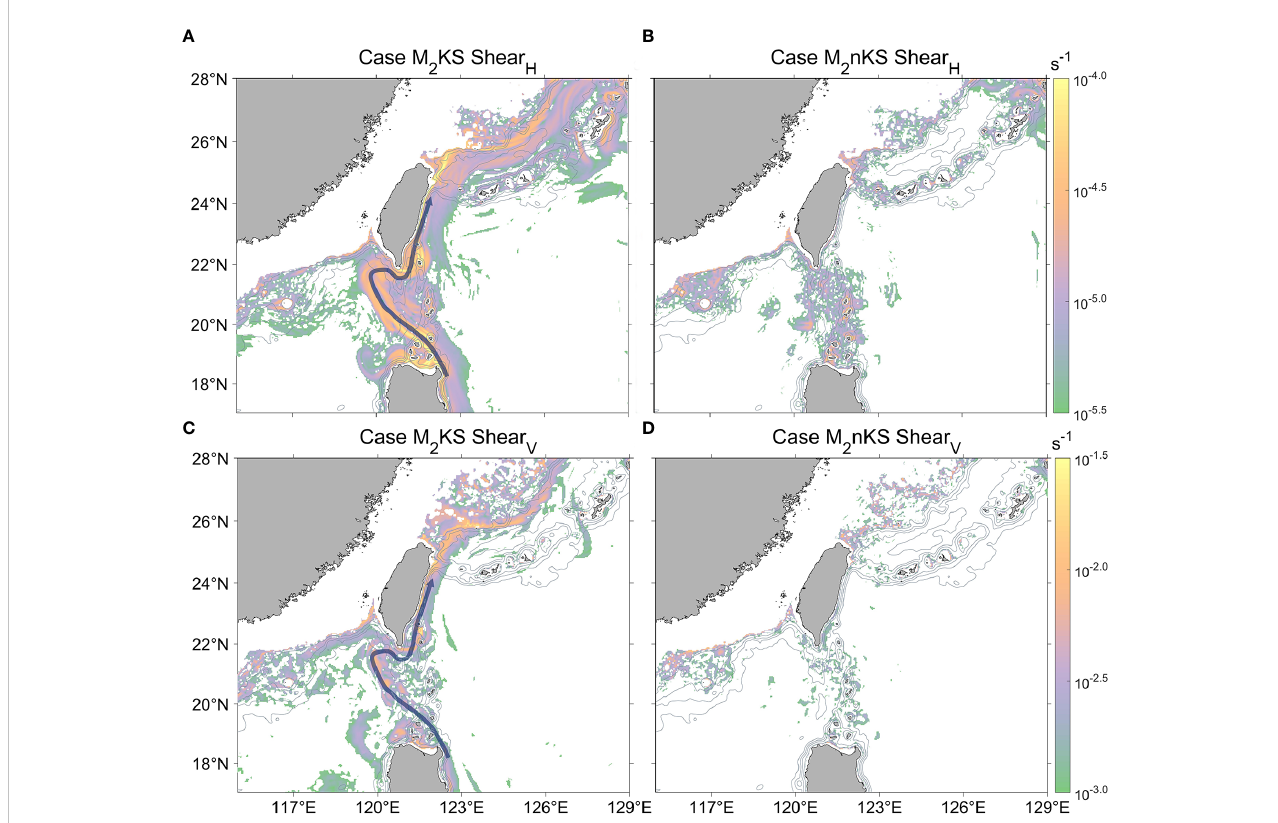
FIGURE 8 Distribution of Shear H and Shear v (color, s -1 ) at 100 m depth for two summer cases (M 2 KS and M 2 nKS). The curved path represents the Kuroshio path. The top row (A, B) is Shear H , and the bottom row (C, D) is Shear v . The left column (A, C) gives the with-Kuroshio case (M 2 KS), and the right column (B, D) shows the without-Kuroshio case (M 2 nKS). Gray contours indicate the